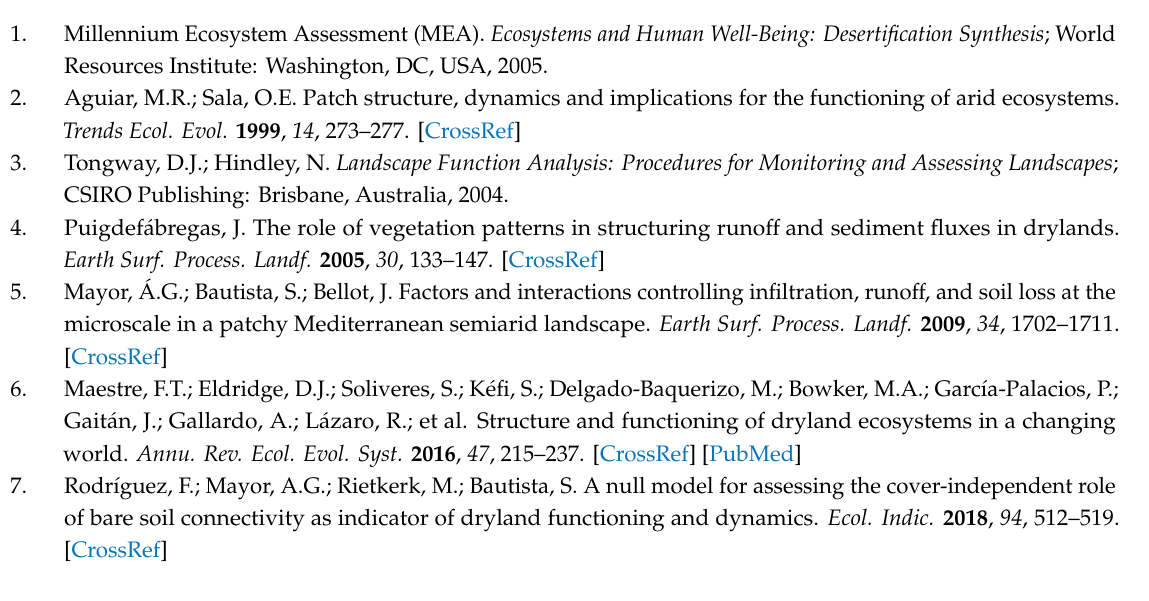
Figure S1: Semi-arid Mediterranean steppes in the study area, Cabezo de la Plata, Murcia, Spain; Figure S2: Schematic illustration of a sampling plot; Figure S3: Relative abundance of ground arthropods taxa found in semi-arid Mediterranean steppe areas in Southeast Spain; Figure S4: Abundance and species richness of ground arthropods found in interpatches and patches as a function of the average distance to the nearest neighbor patches; Table S1: List of taxa and number of morpho-species found in the litter and top-soil layers of fourteen plots of Mediterranean drylands in Southeast